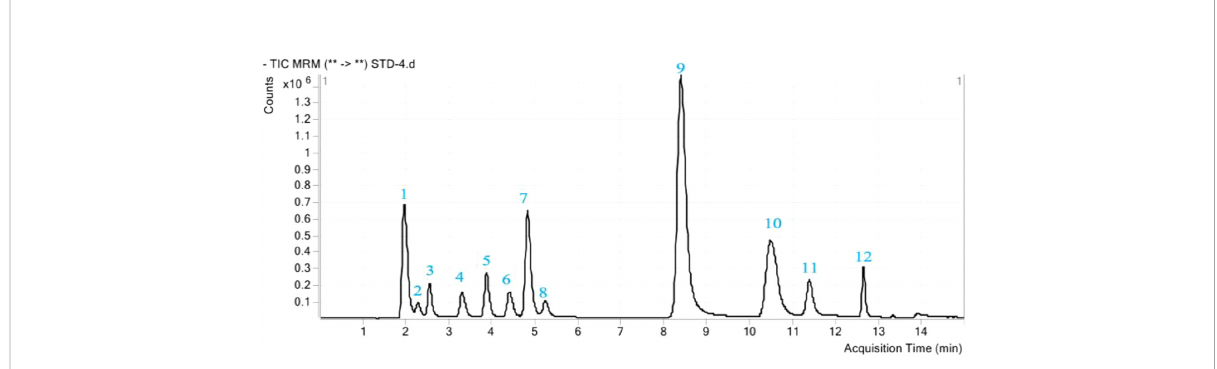
FIGURE 1 A total ion chromatogram (TIC) of phenolic acid mixture standards. The peak number represents the twelve phenolic acids as follows: 1, Pyrogallic acid; 2, Coumaric acid; 3, Protocatechuic acid; 4, Chlorogenic acid; 5, 4-Hydroxy benzoic acid; 6, Caffeic acid; 7, Syringic acid; 8, Vanillin; 9, Ferulic acid; 10, Benzoic acid; 11, Salicylic acid; 12, Cinnamic